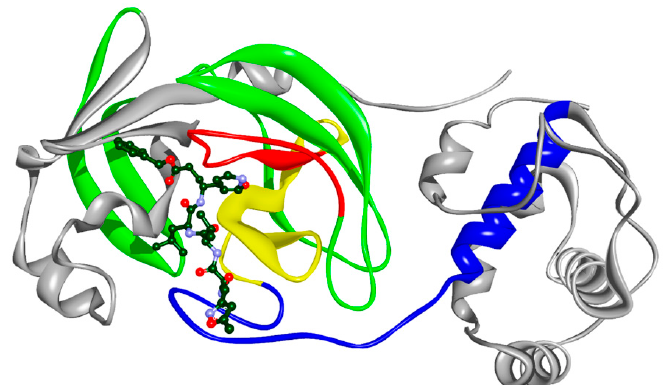
Figure 2. Crystal structure of M pro . Marked regions correspond to F(0.1923) — red (residues 131 – 195), F(0.3183) — yellow (residues 151 – 183), F(0.4414) — green (residues 72 – 136) and F(0.1054) — blue (residues 182 – 214). Note that regions F(0.1923) and F(0.3183) overlap, as well as F(0.4414) and F(0.1923); also F(0.3183) and F(0.1054). The bound compound is the co-crystalized inhibitor N3.